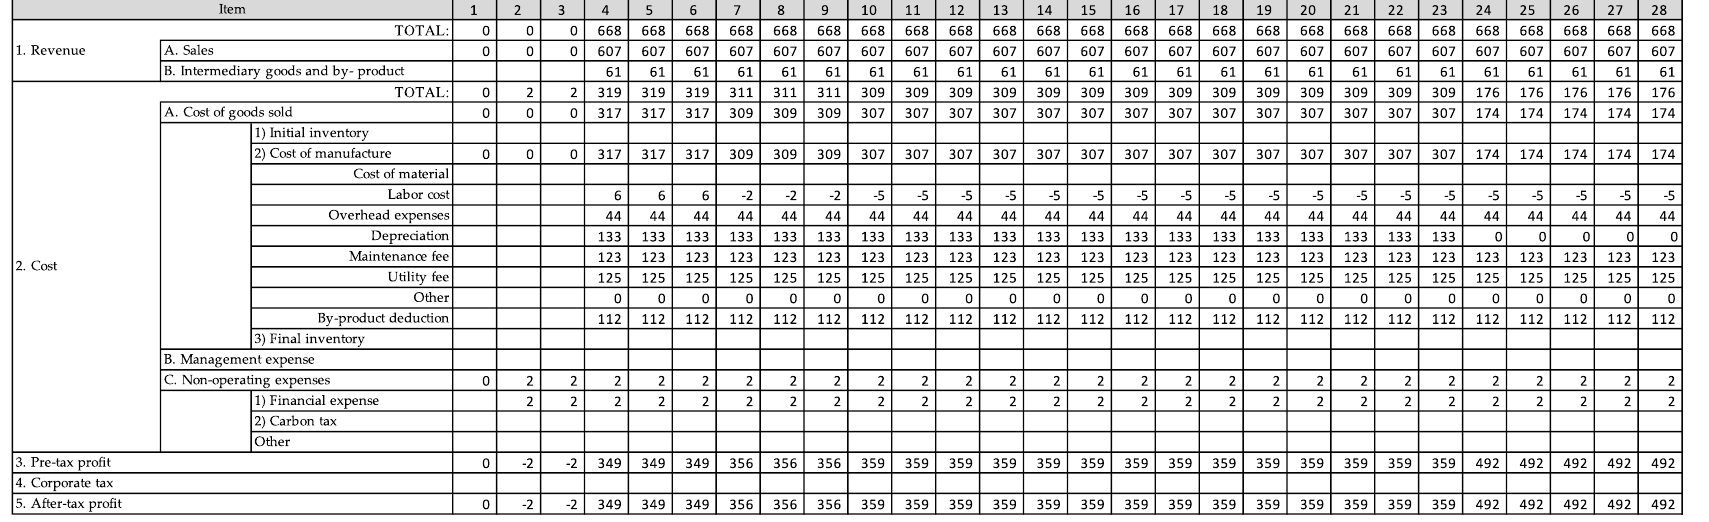
Figure 4. Cost/revenue analysis of typical three mil ton/year steel project ($M USD).